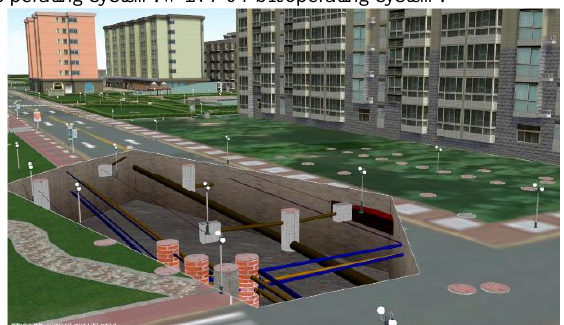
Figure 6. The efficacy of Xijing hospital Data